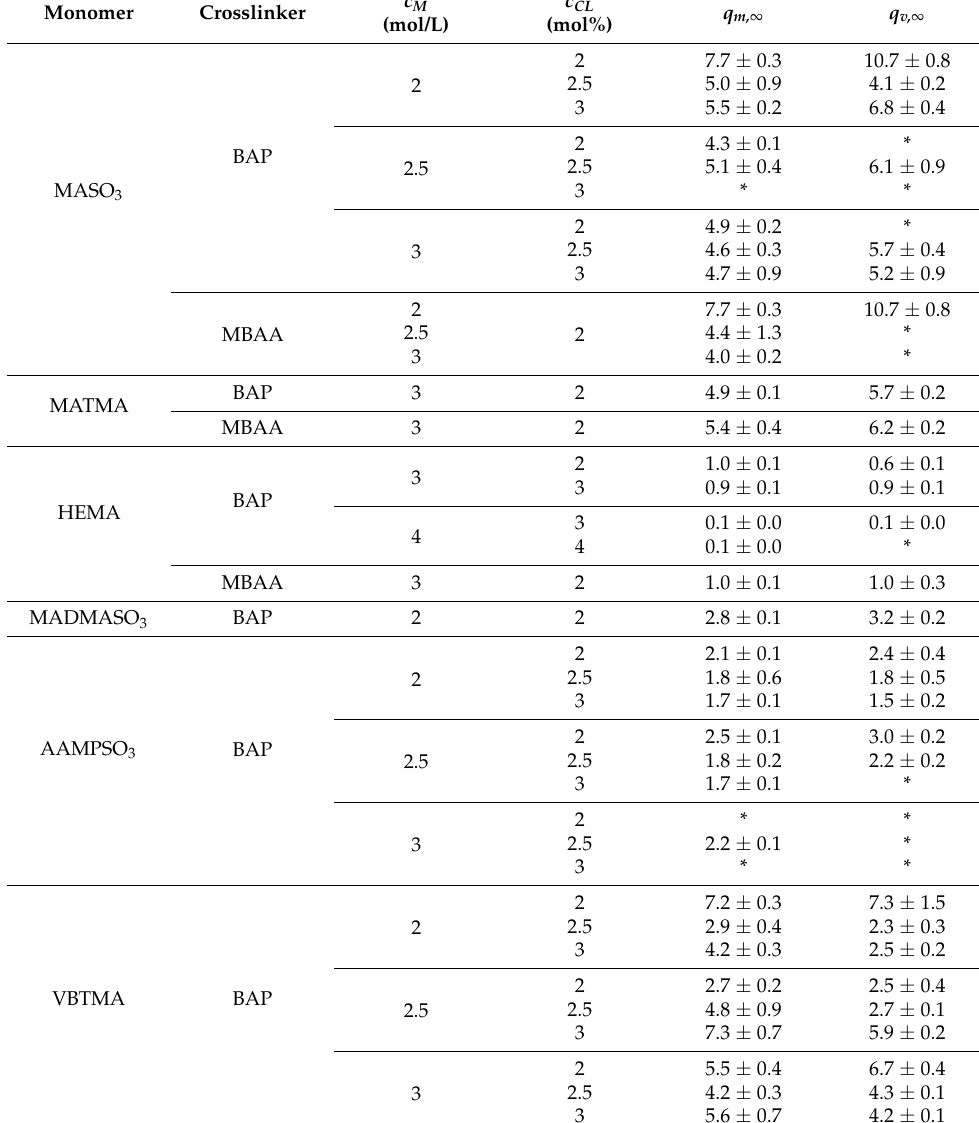
Table 2. Comparison of the volumetric ( q v, ∞ ) and gravimetric ( q m, ∞ ) swelling degree.